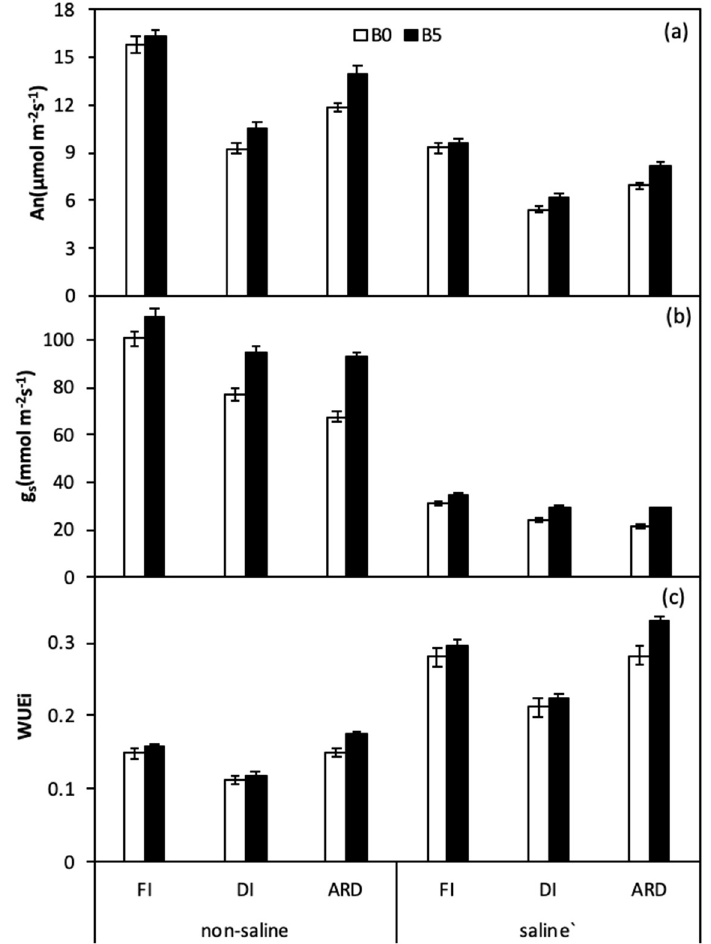
Figure 1. Leaf photosynthesis (A n ) ( a ), stomatal conductance (g s ) ( b ), and intrinsic water use efficiency (WUE i ) ( c ), of quinoa leaves as affected by biochar, irrigation regimes, and salinity. B0 and B5 indicate biochar levels, respectively. FI, DI, and ARD indicate full irrigation, deficit irrigation, and alternate root-zone drying irrigation, respectively. Error bars indicate ±SE ( n = 4). SE indicates standard error.